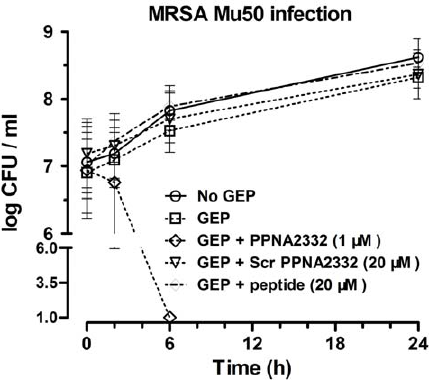
Figure 5. Protective effect of anti- rpoD PPNA2332 on epithelial cell culture infected with noninvasive single MRSA/VISA Mu50 infection. The symbols represent time points of cell harvest (2, 6, and 24 h) and are displayed as the mean number of colony-forming units (CFUs) per milliliter. Error bar represents SD. The 6 h counts for 1 m M PPNA2332 were 0 CFUs/mL. For all observations in co-cultures (GEP + MRSA/VISA Mu50) treated, with the limit of detection indicated as 10 CFUs/mL. Scr PPNA2332, Scrambled sequence control PPNA2332; GEP, gastric mucosa originated epithelial cell.